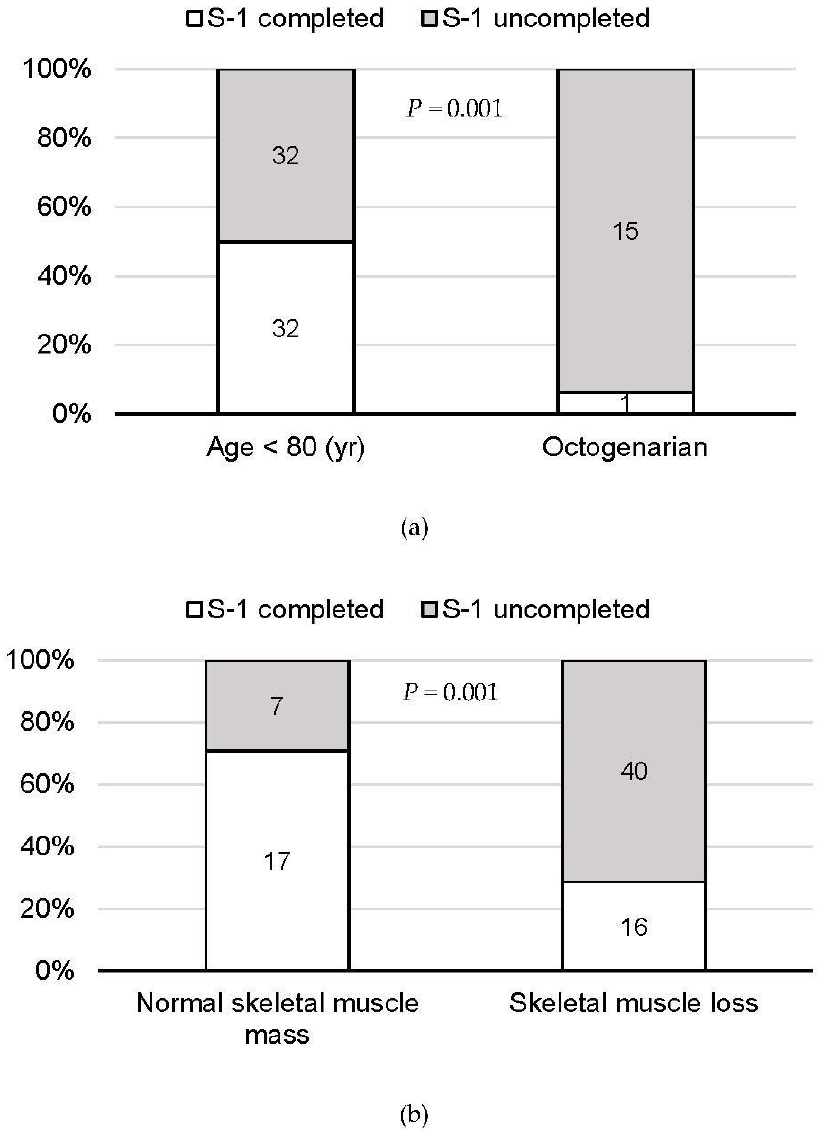
Figure 2. S-1 adjuvant therapy completion rates in ( a ) octogenarian patients and ( b ) those with skel- etal muscle loss.